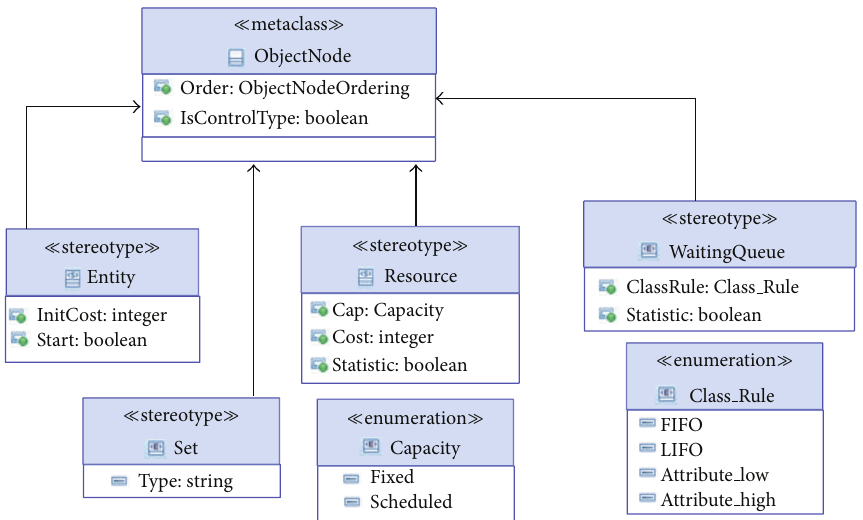
Figure 8: The ObjectNode metaclass with its stereotypes.